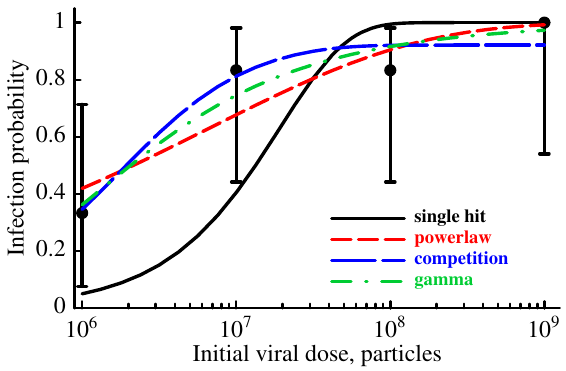
Figure 7. The probability of infection of monkeys with increasing SIV dose is not described well by the simple, single-hit